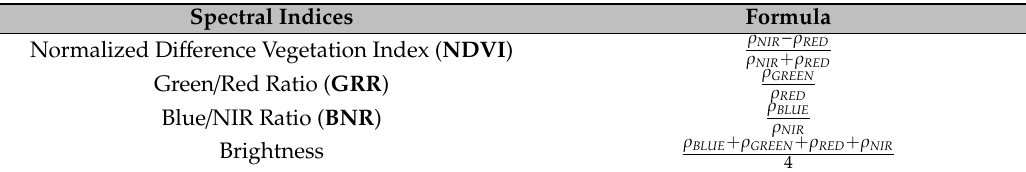
Table 4. Spectral indices used for LCCS classification.